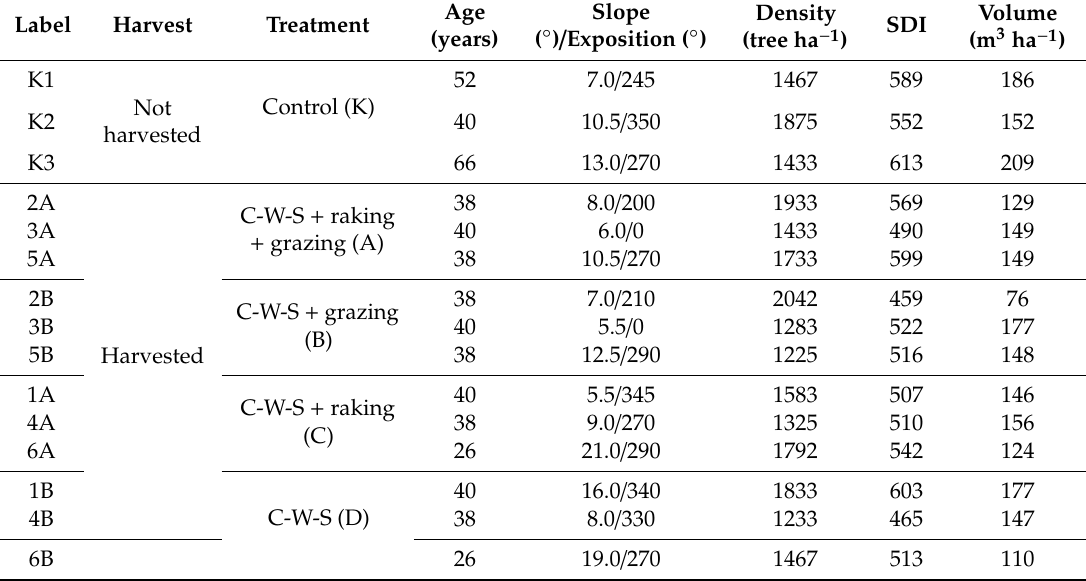
Figure 1. Arrangement of the experimental plots (aerial map (orthophotomap), © Seznam.cz, a.s., © TopGis, s.r.o.). Table 1. Plot characteristics in 2017 prior to harvest.